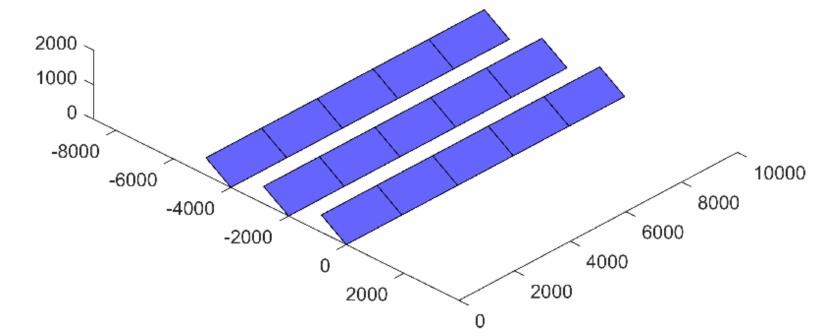
Figure 11. Visual output of a PV array modeled in